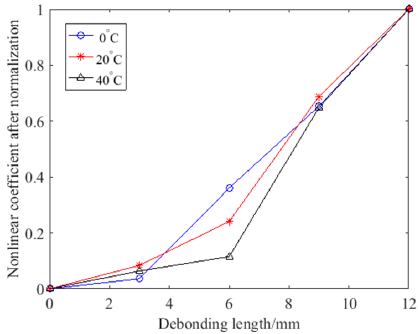
Figure 14. The variation curves of the nonlinear coefficient after normalization under different temperatures.